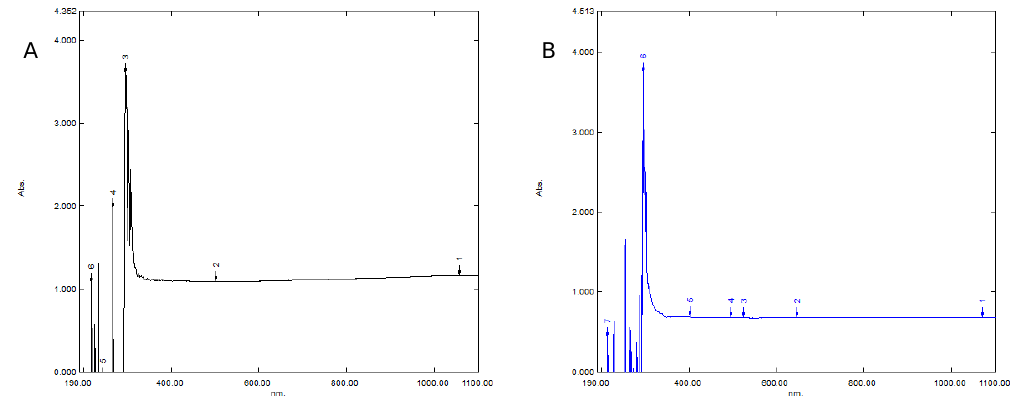
Figure 3. UV–visible analysis for two statuses of maize seed (dry ( A ) and wet ( B )) by wavelength, ranging from 190–1100 nm.